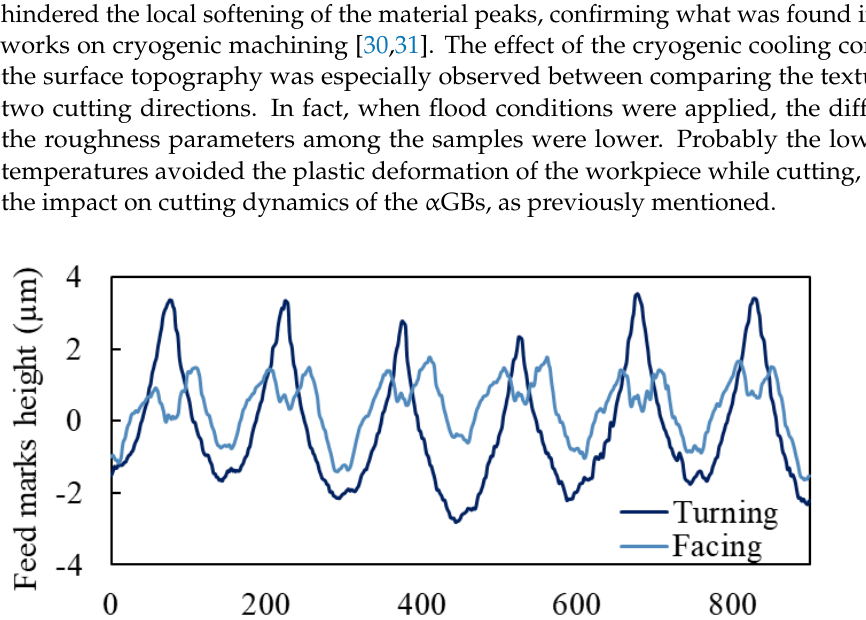
Figure 6. Roughness profile of the feed marks in cylindrical turning and facing under cryogenic cooling.